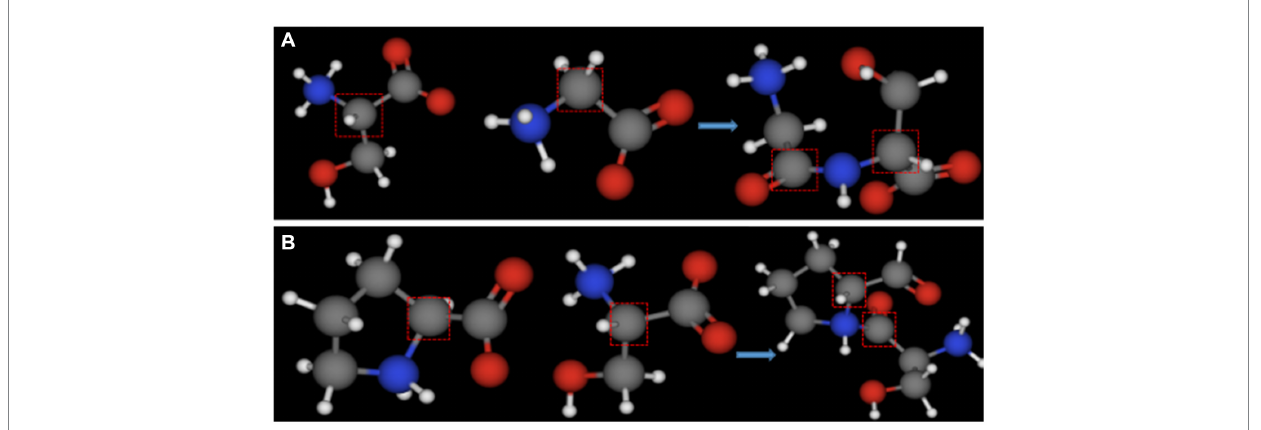
FIGURE 7 Ball-and-stick models of the dipeptide formed by the condensation of different amino acids. (A) Ball-and-stick model of serine and glycine dipeptide; (B) ball-and-stick model of proline and serine dipeptide (the gray part in the red box represents the main chain carbon atom of each amino